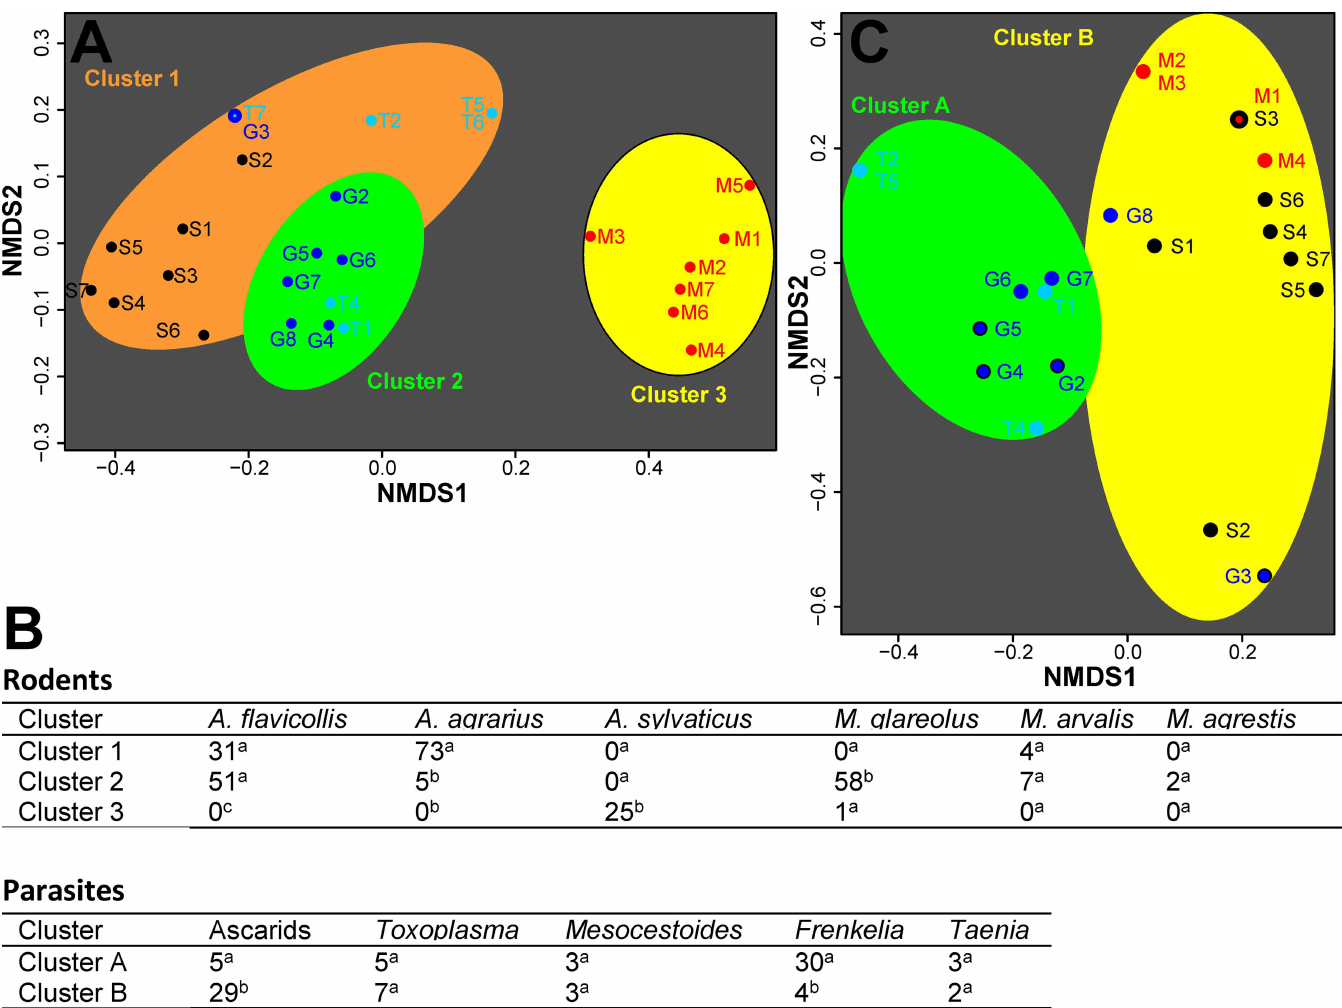
Fig 3. Identification of patterns using non-metric multidimensional scaling (NMDS) and k-means cluster analysis. NMDS plots show similarity for trapped rodent species (A) or parasite-positive rodents (C) for the different trapping sites (G, Gatow, M, Moabit, S, Steglitz, T, Tegel) and trapping blocks (1– 8). Rodentswere considered to be positive for ascarids if the T . canis ELISA was positive or any ascaridspecies was detected by PCR. For every trapping week, the number of rodents of a particularspecies or the numberpositive for a particularparasite was used to calculatea Bray-Curtis dissimilarity matrix followedby NMDS. The matrix was used to identify the minimum numberof k-means clusters which were indicatedon the NMDS plots using ellipses of different colors. (B) Clusters were analyzedfor differencesin the proportions of particularrodent or parasitespecies (species relative to total numberin that cluster) using mid-P exact tests. Numbers with different indicesin the same column indicate significantdifferences (p < 0.01)while identicalindices indicate non-significant differences (p >